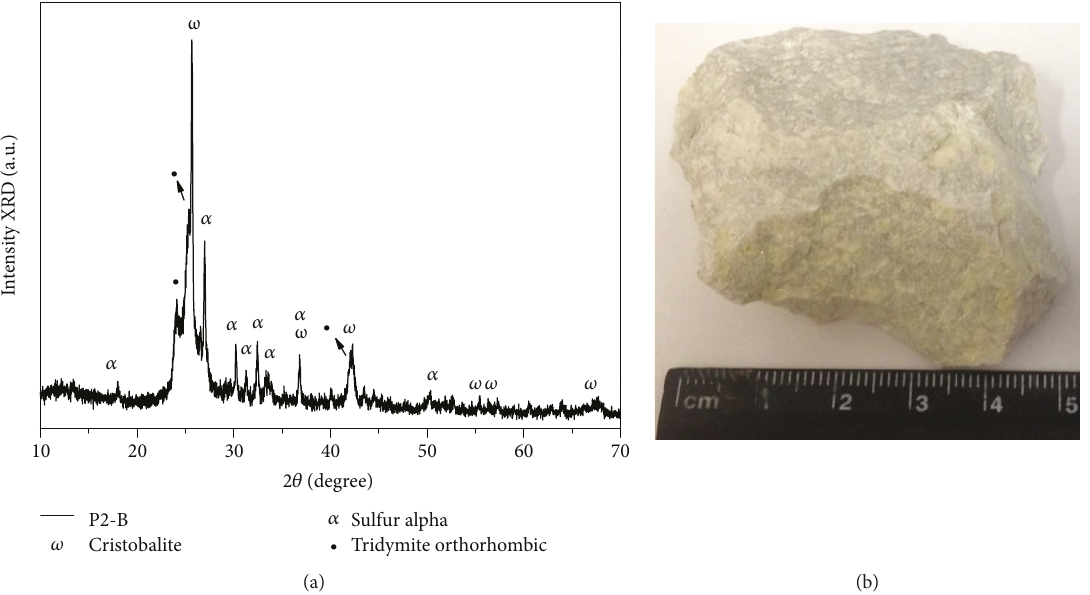
Figure 12: Sample P2-B (a) XRD patterns and (b) rock sample of crystalline tu ff